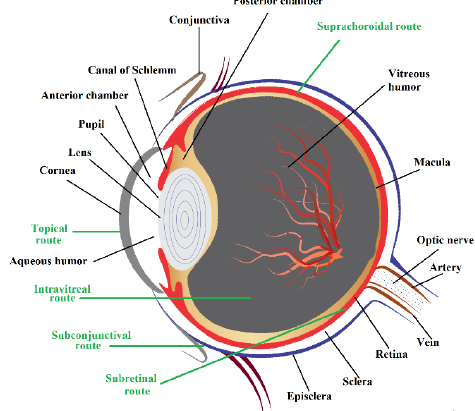
Figure 1. Schematic diagram depicting the key regions and various ocular routes of drug administra- tion in the human